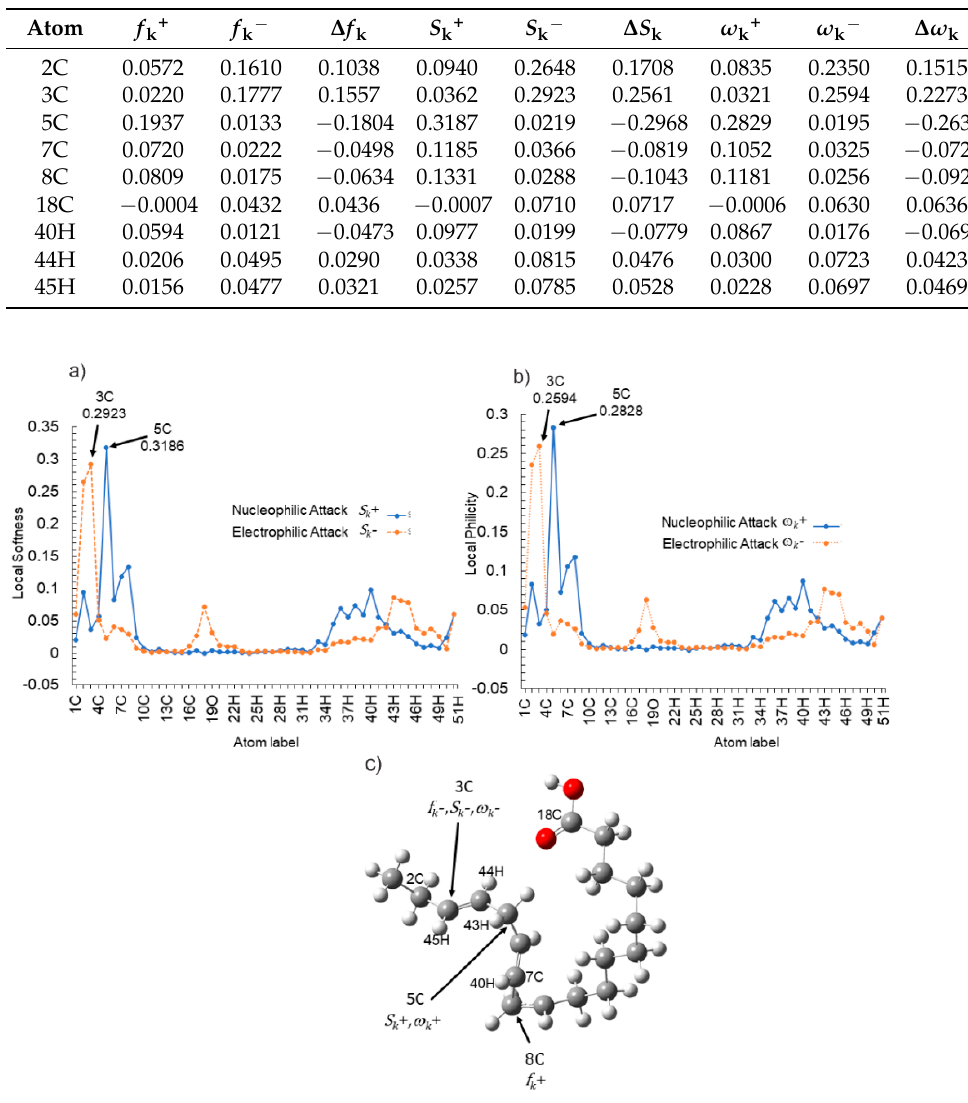
Table 7. Fukui functions, local softness, local philicity, dual Fukui functions, dual local softness and dual local philicity for the protonated α -linoleic acid molecule with Hirsfeld charges.